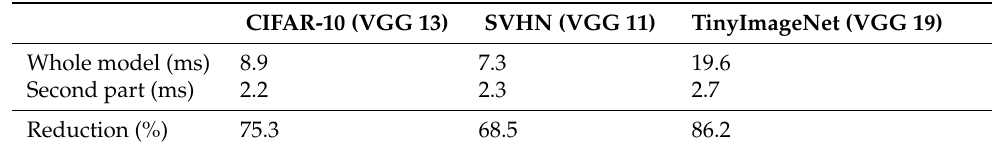
Table 8. Runtime of the training in milliseconds, including running the models, calculating the gradients, and adjusting the